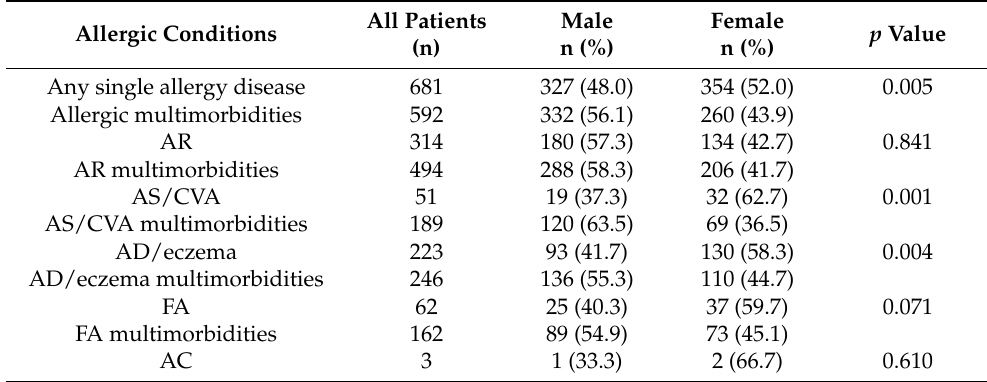
Table 2. Comparison of sex difference between different allergic conditions.